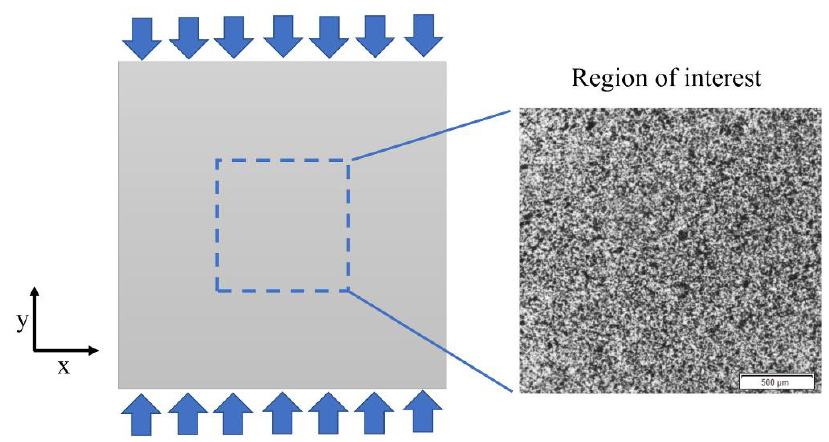
Figure 3. Test overview with detailed view on the speckle pattern in the region of interest.